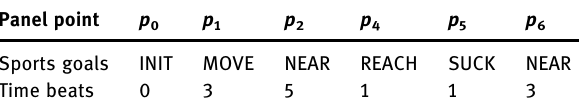
Table 1: Description of sorting process Panel